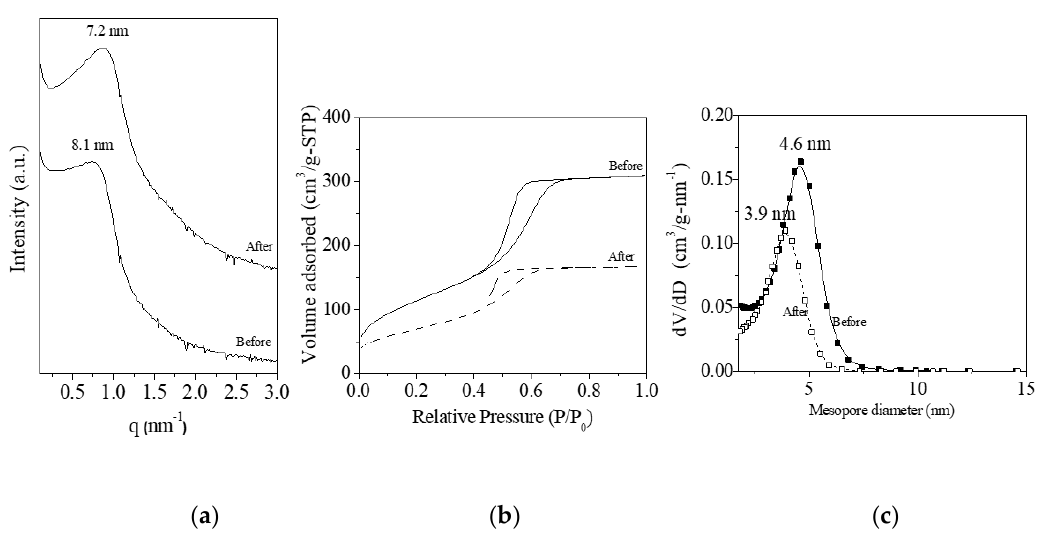
Figure 1. Small Angle X-ray Scattering (SAXS) pattern ( a ), nitrogen adsorption–desorption isotherms, ( b ) and mesopores size distribution ( c ) of the bare and of the impregnated amorphous mesostructured ZrO 2 .